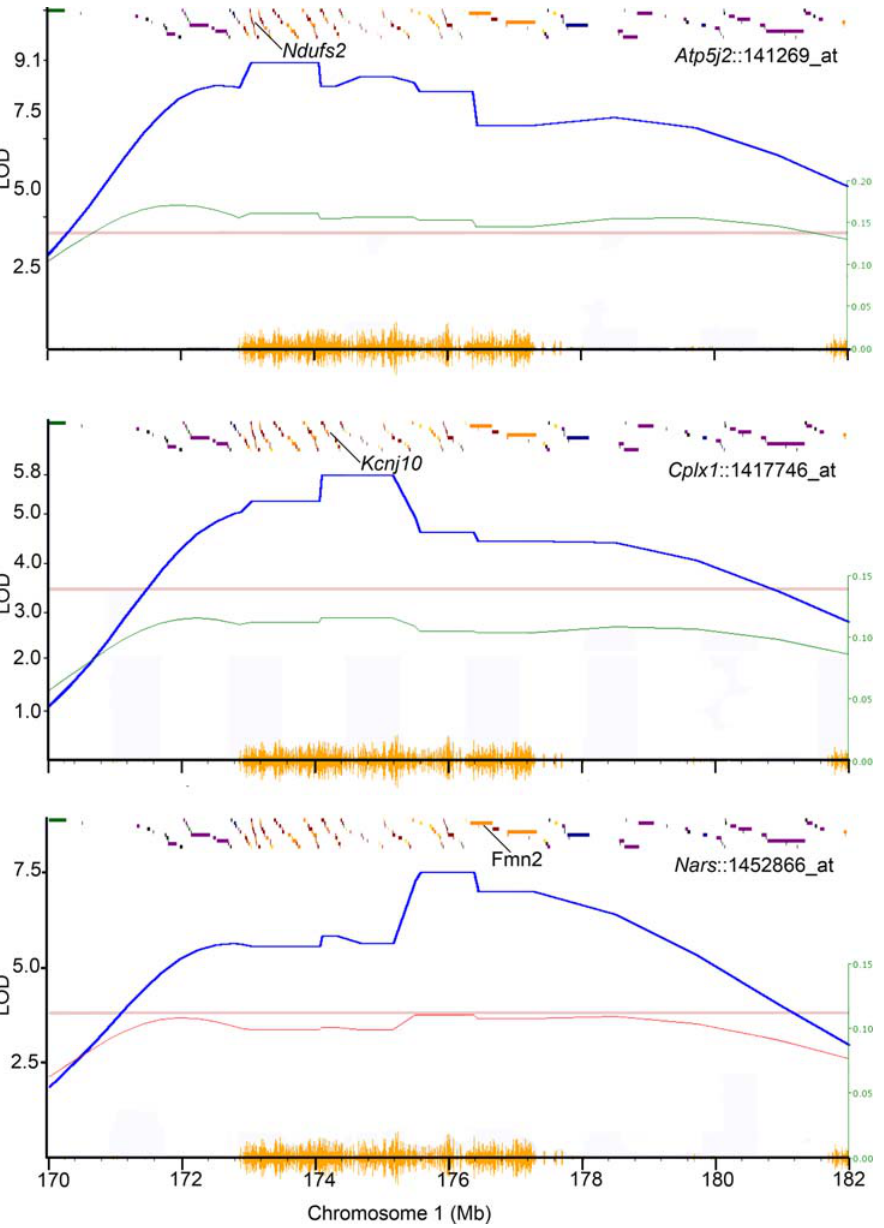
Figure 4. Segregation of trans -QTLs in Qrr1 . Expression of Atp5j2 , Cplx2 , and Nars are modulated by trans -QTLs in Qrr1 (blue plot). D allele has the positive additive effect (green plot; allele effect scale shown on the right) on the expression of Atp5j2 and Cplx2 ; peak LOD scores are on markers near candidate genes Ndufs2 and Kcnj10 . B allele has the positive additive effect (red plot) on the expression of Nars ; peak LOD score is on markers near candidate gene Fmn2 . The horizontal lines indicate the genome-wide significant thresholds ( p -value=0.05). Yellow seismograph tracks the SNP density between B and D alleles. Affymetrix probe set ID for each transcript in the BXD hippocampus dataset is shown.